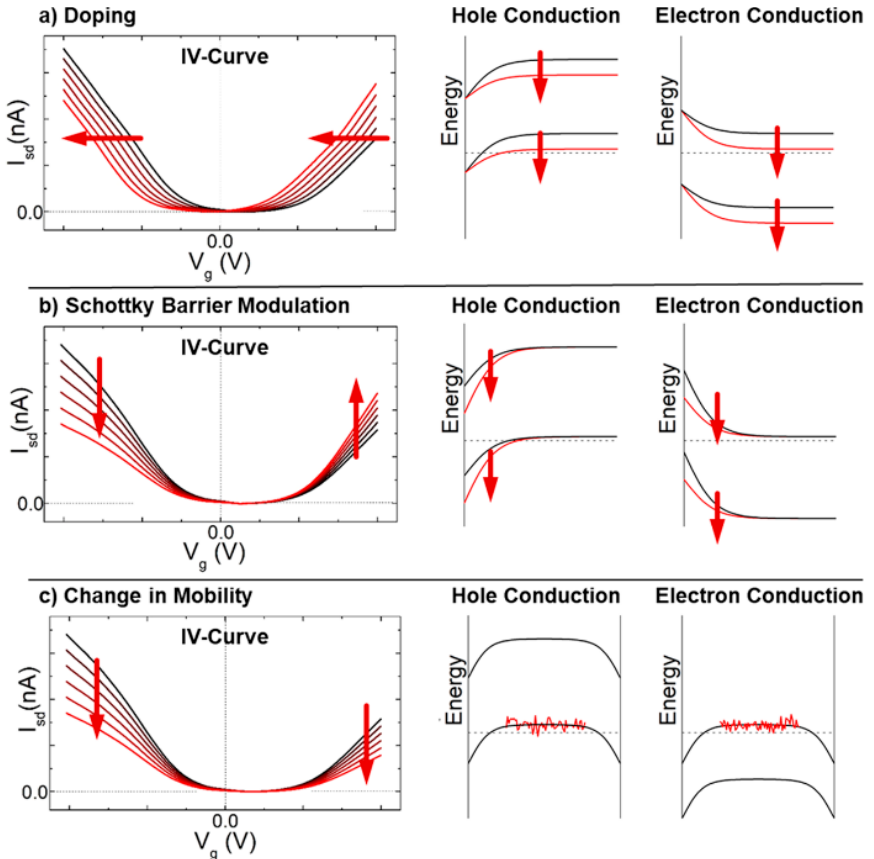
Figure 6. Theoretical I-V curves of a chemFET depending on ( a ) the doping ( b ) Scottky barrier modulation ( c ) change in mobility. Reprinted with permission from [15]. Copyright (2018) from American Chemical Society.